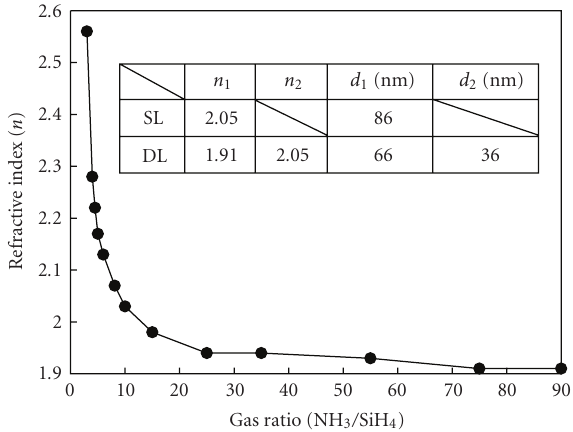
Figure 1: Refractive indices ( n ) of Si 3 N 4 films deposited with di ff erent ratios of gas-flow rate. The inset table is the measured n with corresponding thickness ( d ) values for SL and DL AR